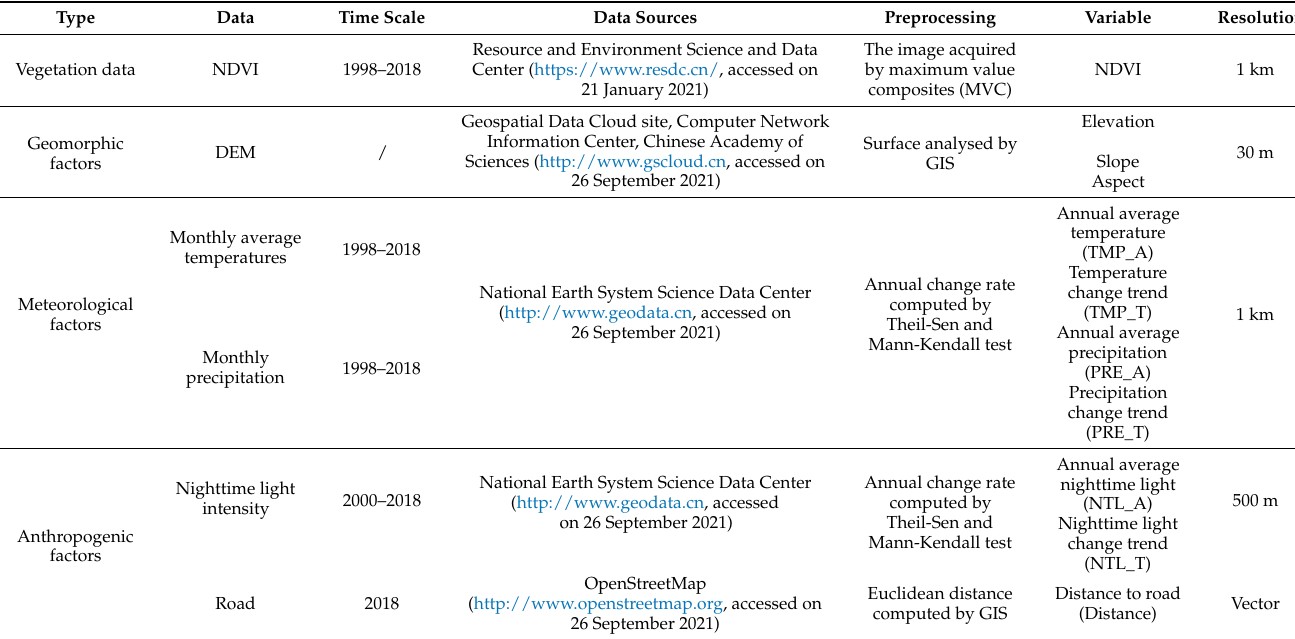
Table 1. Data sources and